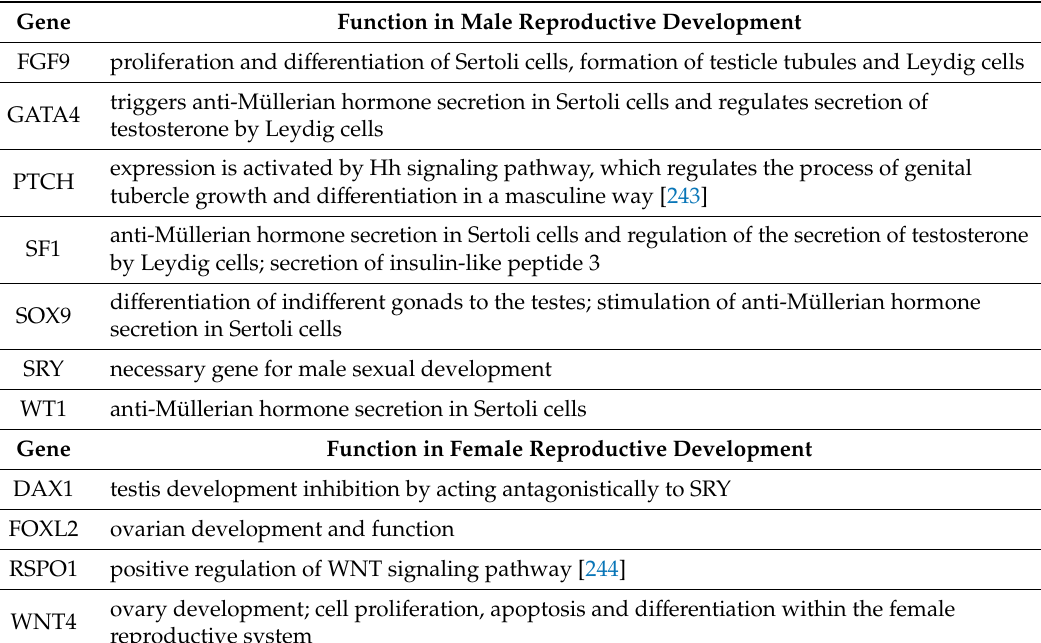
ovary development; cell proliferation, apoptosis and di ff erentiation within the female reproductive